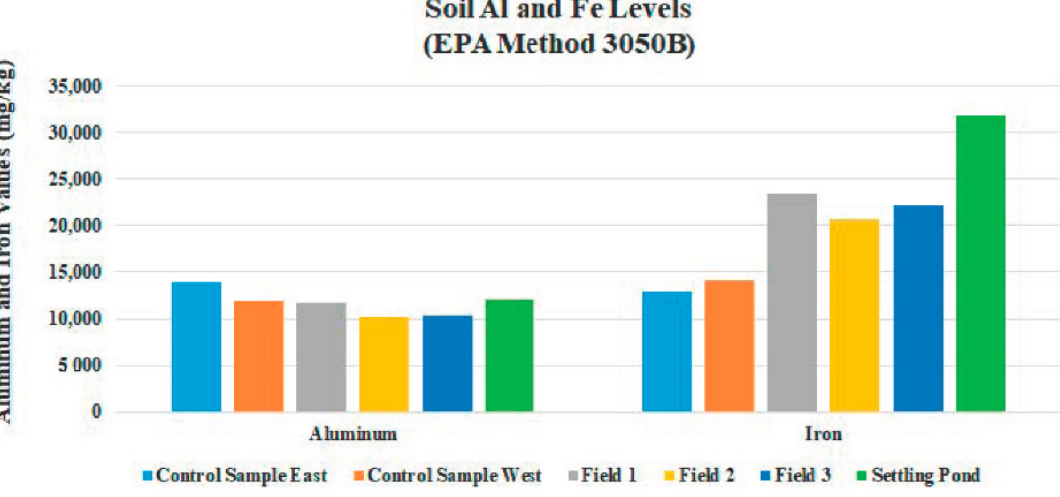
Figure 10. Mean values for aluminum and iron of Fields 1, 2, and 3 and Control Samples East and West.